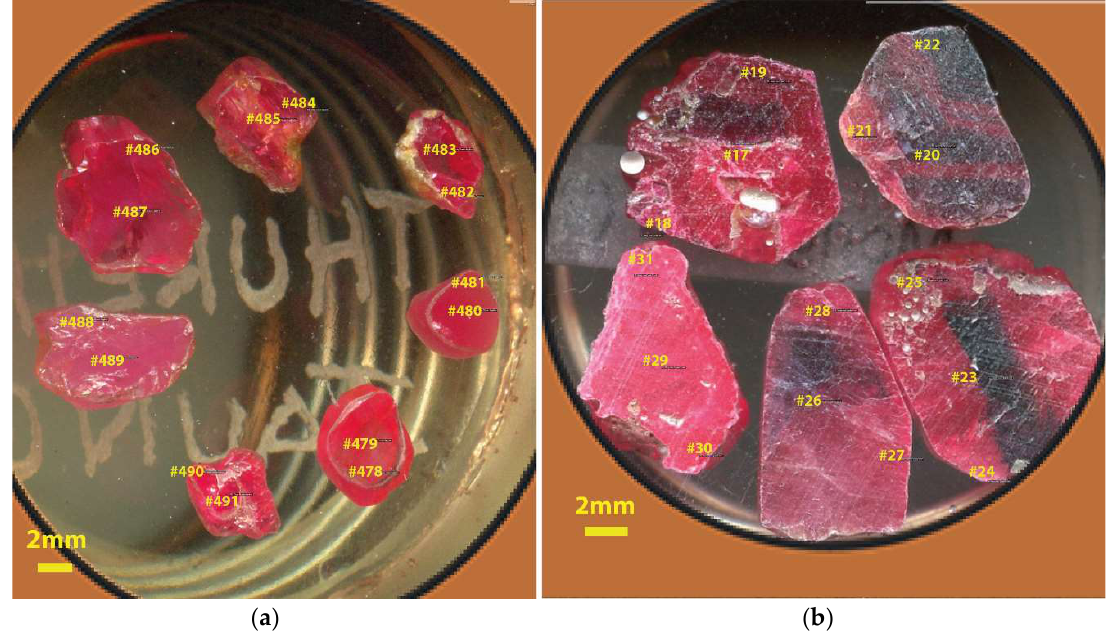
Figure 6. Photos showing mineralogical and textural characteristics of Mogok and Mong Hsu ruby samples. ( a ) Thurein Taung ruby crystals embedded in 25 mm diameter mount. ( b ) Mong Hsu ruby crystals embedded in 25 mm diameter mount. Yellow # nos. are analytical spots, listed in Tables A1 and A2.